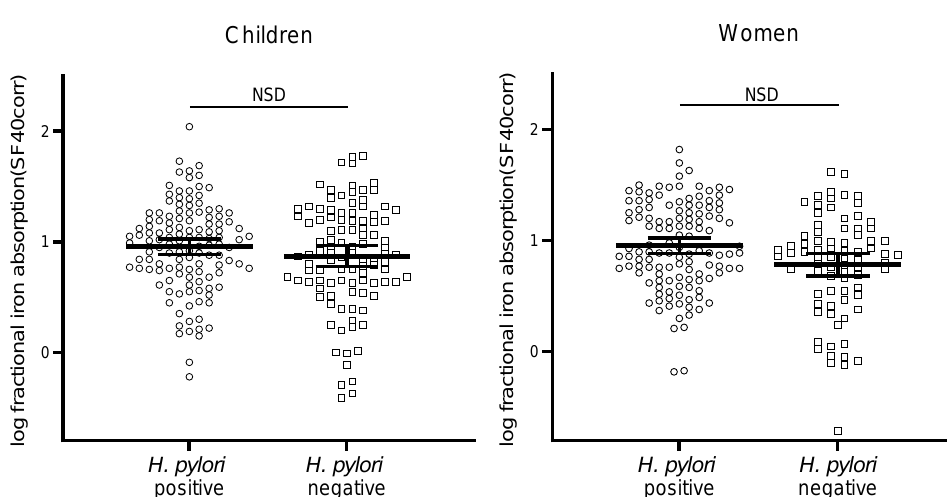
regression to assess the minimal adequate model.